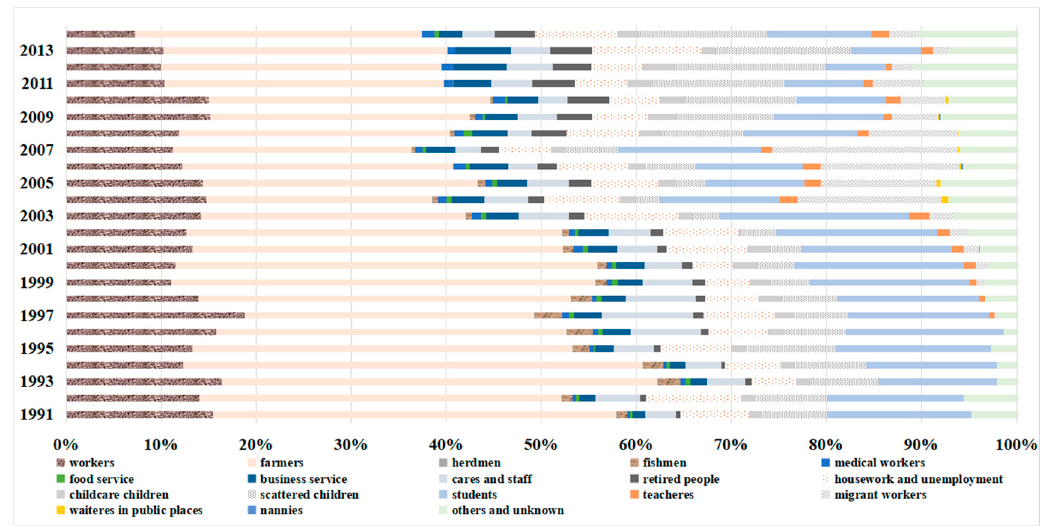
Figure 9. The proportion of different careers in all patients in Zhejiang from 1991 to 2014.